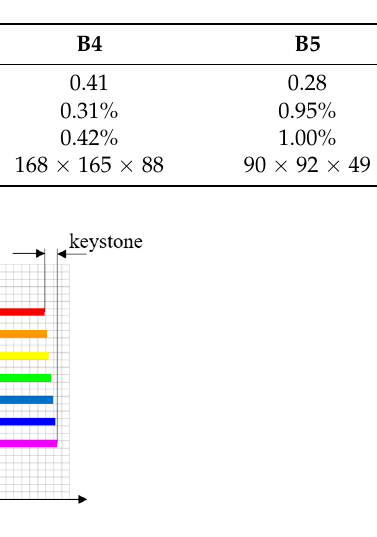
Figure 6. Profile map of spectrometers in GeoFWHIS. ( a – e ) from B1 band to B5 band. Table 4. System parameters and performance of spectrometers.